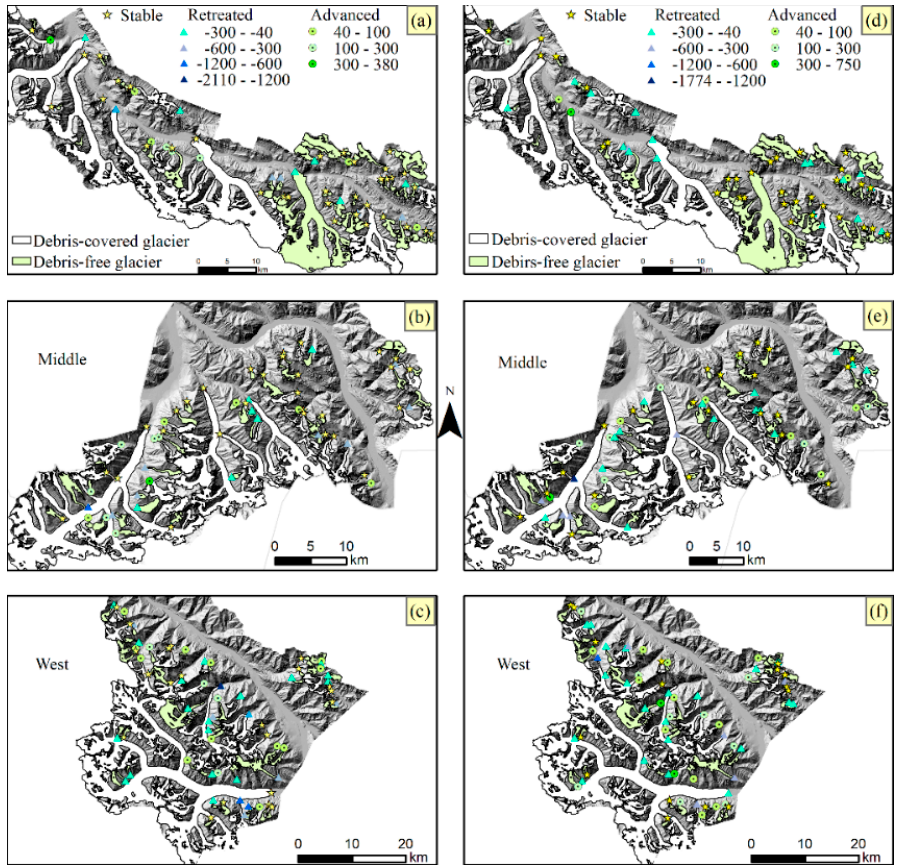
Figure 13. Variations of glaciers terminus position during the 1970–1980 ( a – c ) and 1980–1990 ( d – f ) periods (unit: meter).